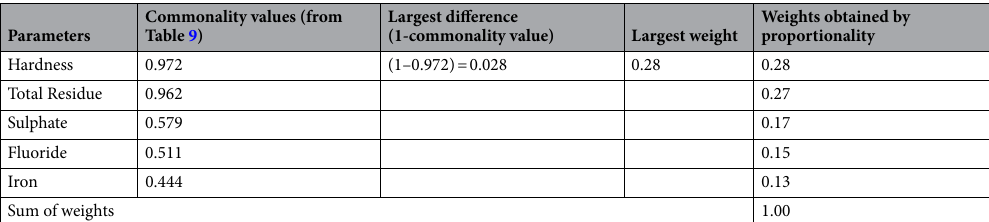
Table 7. Description how to obtain the relative weight (w i ) of each